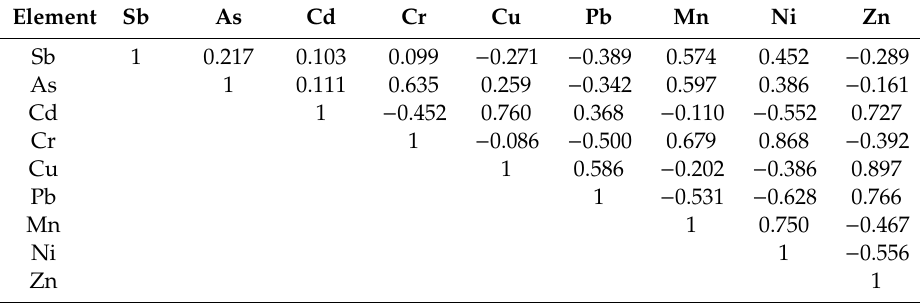
Table 3. The correlation coe ffi cients between chemical elements of the sediments in the Blyde River. Element